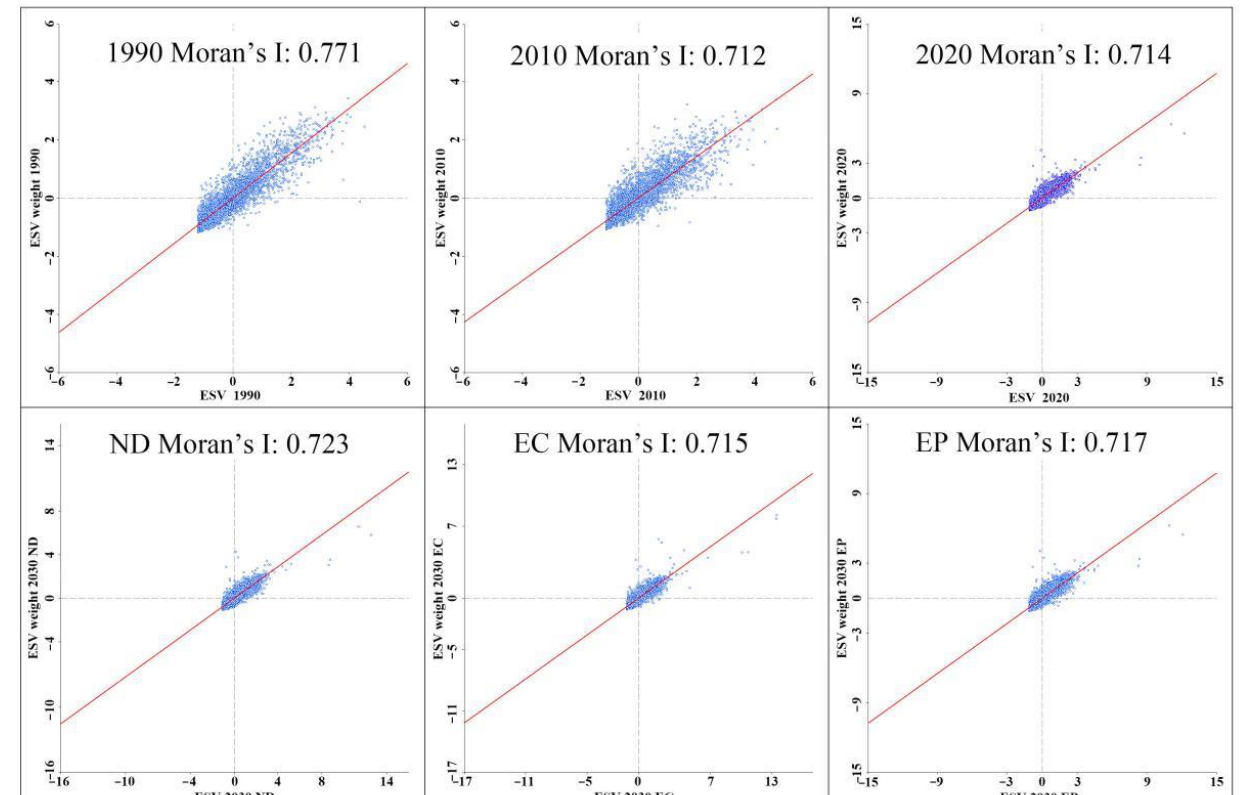
Figure 6. Moran scatter plots of the Ecosystem Service Values in the study area. Note: ND, natural development; EC, ecological conservation; EP, economic priority.